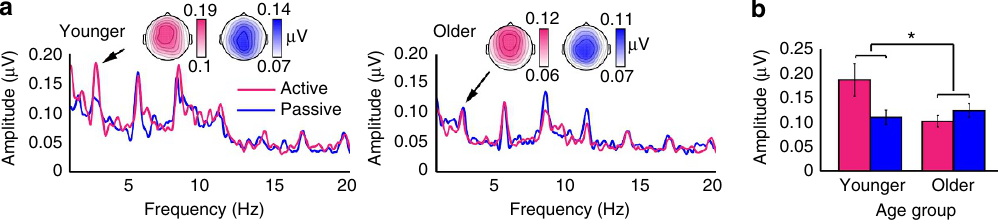
Figure 2 | Attention effects on entrainment were larger for younger than for older adults. ( a ) Frequency-domain representations of the EEG signal for active (pink) and passive (blue) listening to FM stimuli, shown separately for younger (left) and older (right) averaged over a fronto-central electrode cluster: Fz ,F3, F4, FC3, FC4, Cz, C3, C4. ( b ) 2.8Hz spectral amplitude: a significant interaction between age and attention resulted from stronger effects of attention (active minus passive) for younger as compared to older adults ( P ¼ 0.04). Error bars show s.e.m. n ¼ 20 younger, n ¼ 20 older); false alarm rates: z ¼ 1.18, from the effect of attention (that is, the difference between active and passive conditions) being larger for younger than Fig. 1c). Equalizing performance across age groups required for older adults (Fig. 2b; t (38) ¼ 2.14, P ¼ 0.04, r ¼ 0.33 presenting older listeners with slightly (but not significantly) (independent-samples t -test, n ¼ 20 younger, n ¼ 20 older)), in longer gaps than younger listeners ( z ¼ 1.35 , P ¼ 0.09, r ¼ 0.27 line with older adults lacking entrainment flexibility. Moreover, (rank-sum test, n ¼ 20 younger, n ¼ 20 older); Fig. 1c), in line younger adults’ entrainment strength was significantly greater with previous research indicating that gap-detection thresholds than older adults’ for the active ( t (38) ¼ 2.42, P ¼ 0.02, r ¼ 0.37 become worse with age 46,47 . The degree to which gap-detection (independent-samples t -test, n ¼ 20 younger, n ¼ 20 older)), but performance depended on the phase of the FM into which the gap not for the passive condition ( t (38) ¼ 0.69, P ¼ 0.49, r ¼ 0.11 fell (stimulus-driven behavioural modulation) did not differ (independent-samples t -test, n ¼ 20 younger, n ¼ 20 older)). A between groups r ¼ 0.24 parallel ANOVA on spectral amplitudes from the 5.6 Hz (that is, (independent-samples t -test, n ¼ 20 younger, n ¼ 20 older); second harmonic) bin did not yield any modulation by either age Fig. 1c). Sensory-driven entrainment differs between age groups . Sensory-driven entrained neural responses were calculated using a fast Fourier transform (FFT). Spectral amplitudes ( m V) from the 2.8-Hz frequency bin (Fig. 2a) were submitted to a 2 (cid:3) 2 mixed-measures analysis of variance (ANOVA) with the factors age (between-participants, younger ( n ¼ 20), older ( n ¼ 20)) and attention (within-participant, active, passive), which yielded a main effect of age ( F (1,38) ¼ 4.42, P ¼ 0.04, Z p 2 ¼ 0.10) and an Age (cid:3) Attention interaction ( F (1,38) ¼ 4.60, P ¼ 0.04, Z p 2 ¼ 0.11); range of the P1, N1 and P2 components (independent-samples t -tests, n ¼ 20 younger, n ¼ 20 older) revealed significant the main effect of attention did not reach significance differences for the N1 and P2 (P1: t(38) ¼ (cid:2) 1.63, P ¼ 0.11, ( F (1,38) ¼ 2.74, P ¼ 0.11, Z p 2 ¼ 0.07). The interaction resulted NATURE COMMUNICATIONS|8:15801|DOI: